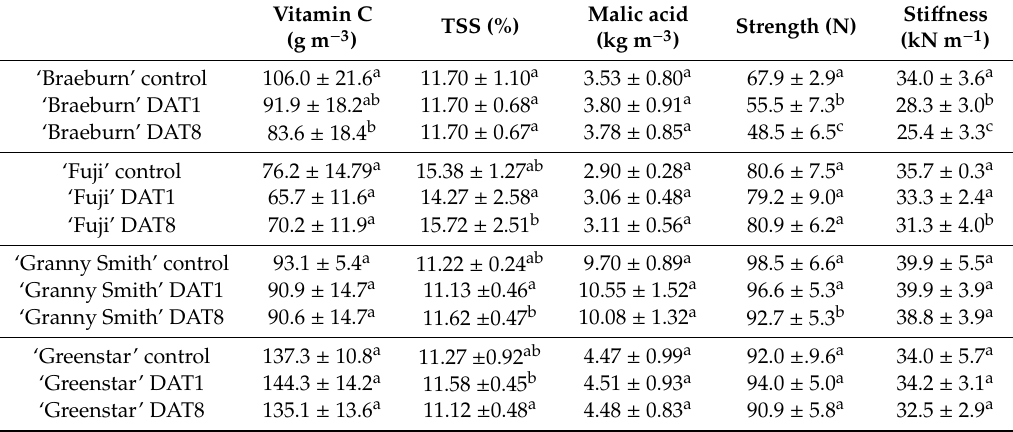
Table 1. Means of vitamin C, total soluble solids (TSS), and titratable acidity contents (given as malic acid content in kg m − 3 ), and tissue strength and sti ff ness (Young’s modulus) in untreated controls, and in fruit stored at 4 ◦ C for 1 and 8 d after treatments (DAT). As HWT showed no e ff ect on either parameter, values were averaged over all treated and untreated samples ( ± SD) to indicate di ff erences between fruit of the di ff erent cultivars. Small letters indicate significance of di ff erences between